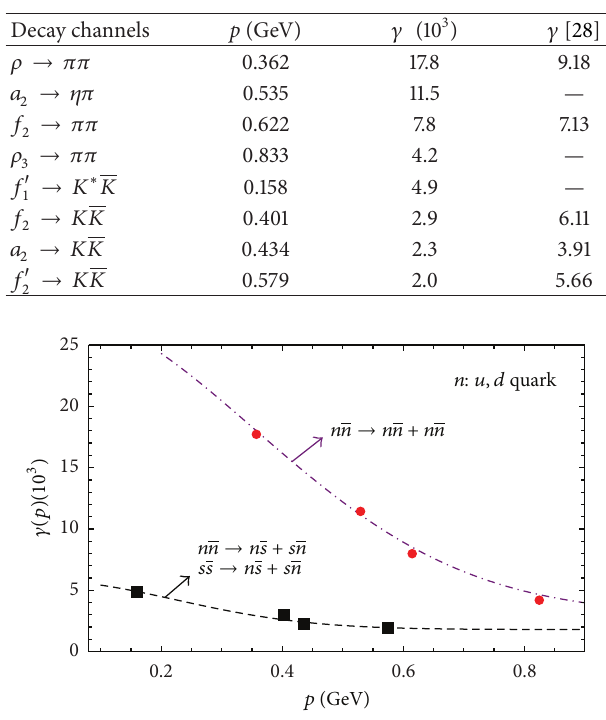
Figure5:Thefunctionsof 𝛾(𝑝) = 𝐴+𝐵 exp (−𝐶𝑝 2 ) indifferentdecay processes. The symbols of red “ e ” and black “ ◼ ” denote 𝛾 values determined by the experimental